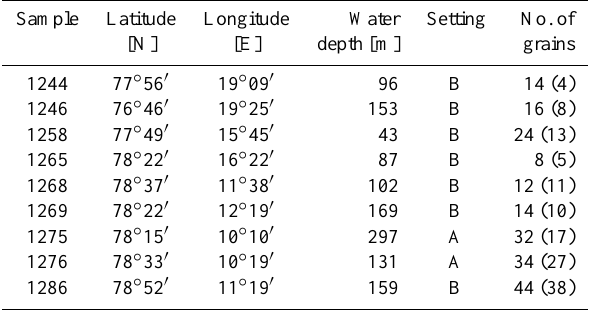
Table 1. Studied sea-floor samples and environmental settings (see text for definition). The number of grains represent all quartz grains >500µm which were found and investigated by optical microcopy, BSE and SEM-CL imaging. The numbers in parentheses indicate the number of LA-ICP-MS